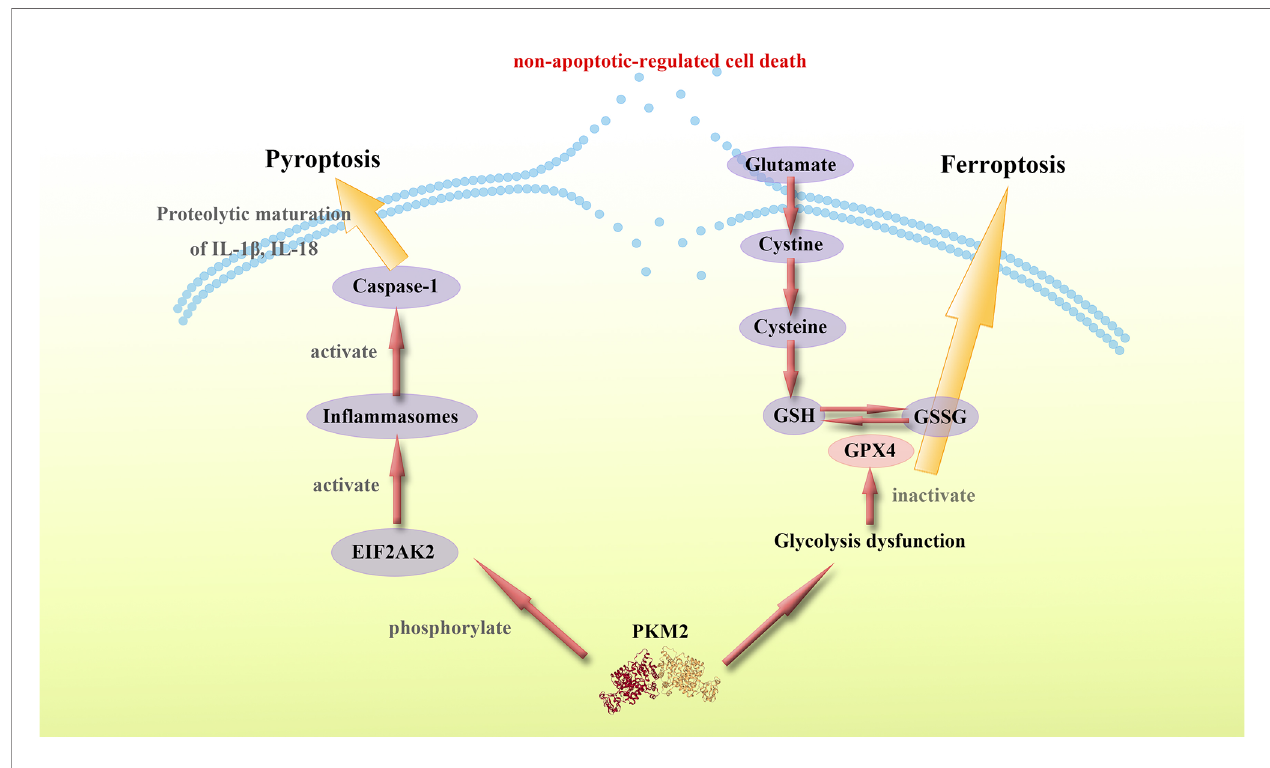
FIGURE 3 | PKM2 mediates proin fl ammatory non-apoptotic-regulated cell death. PKM2 mediates proin fl ammatory non-apoptotic-regulated cell death such as pyroptosis and ferroptosis. The speci fi c mechanisms by which PKM2 regulates pyroptosis and ferroptosis remain unknown, however, a considerable number of studies imply a potential connection between PKM2 and these non-apoptotic-regulated cell death. PKM2-dependent glycolysis promotes EIF2AK2 phosphorylation and in fl ammasome activation, while the activation of in fl ammasome also activates Caspase-1 and thus leading to pyroptosis. Moreover, PKM2-mediated Warburg effect can induce ferroptosis. The glucose metabolism dysfunction caused by PKM2 mediates the reducibility function of GSH, leading to ferroptosis. Thus, targeting PKM2 is a potential approach of regulating proin fl ammatory non-apoptotic-regulated cell